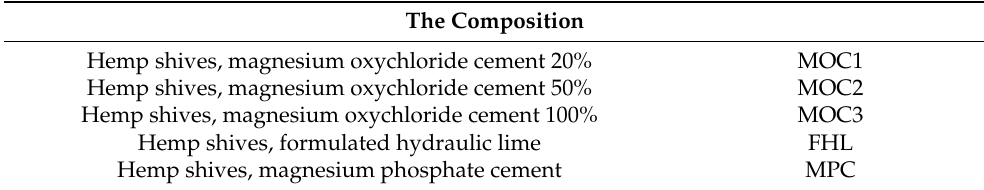
Table 3. Composition of previously studied environmentally friendly composite materials and their